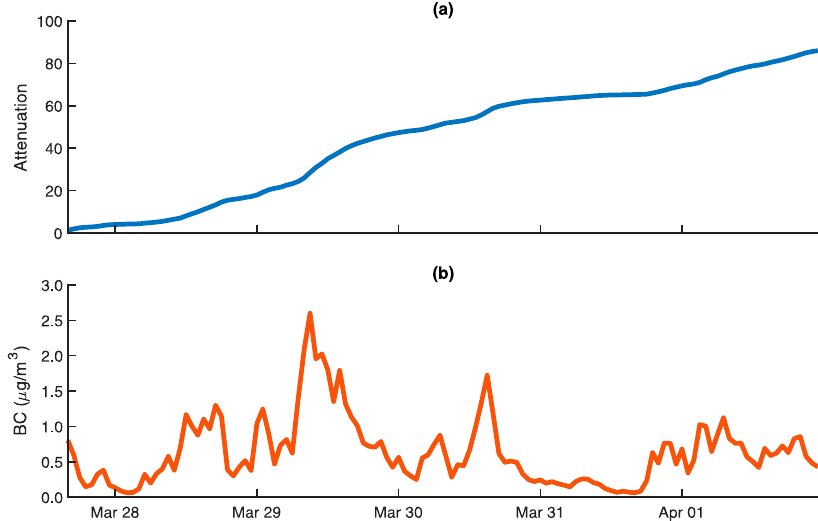
Figure A3. Temperature-compensated data calculated by an ABCD operating outdoors: ( a ) Optical attenuation; ( b ) Black carbon (BC) mass concentration. All data is provided on a 60-min time base.